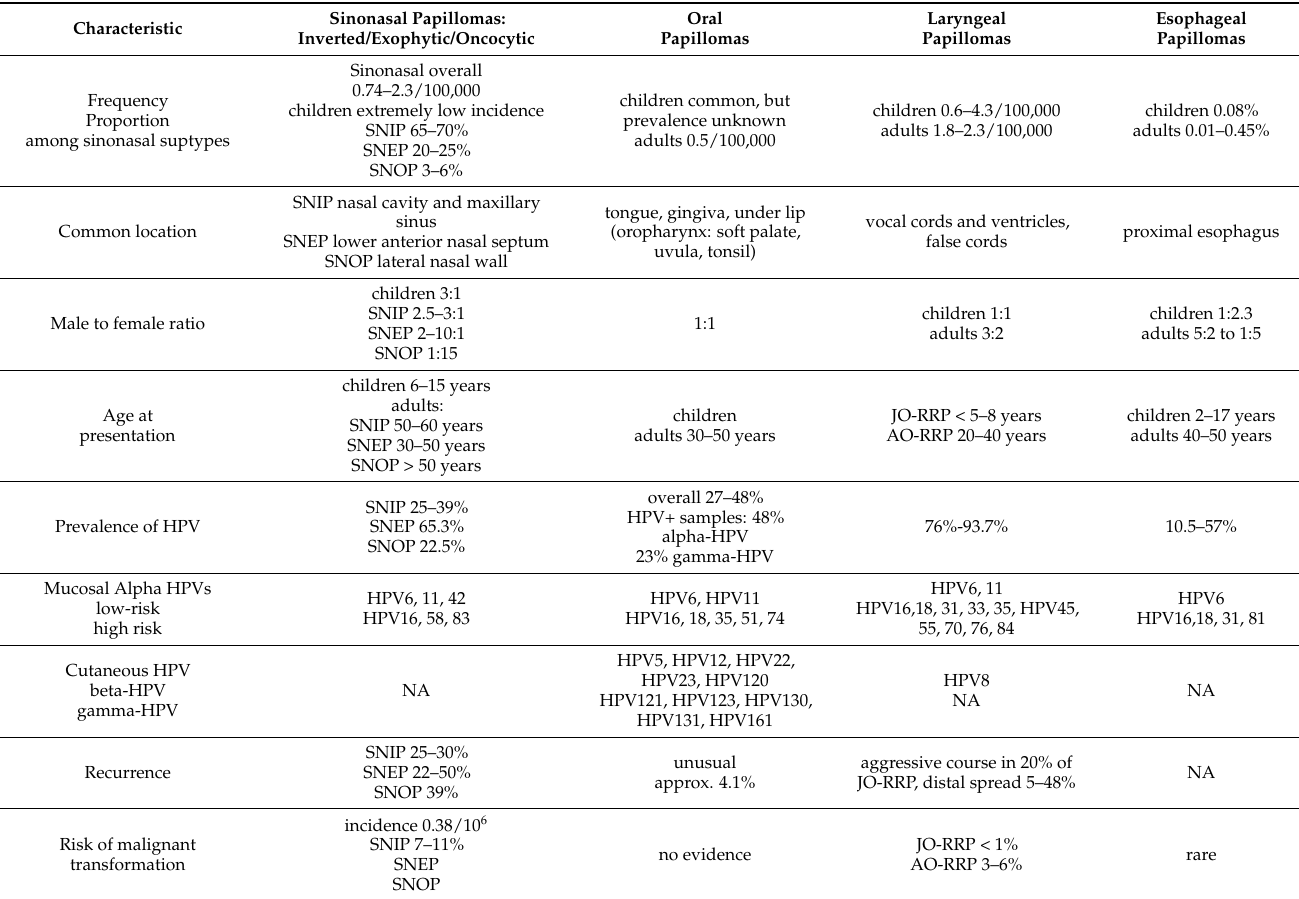
Table 1. Summary of the squamous cell papillomas in the upper aero-digestive